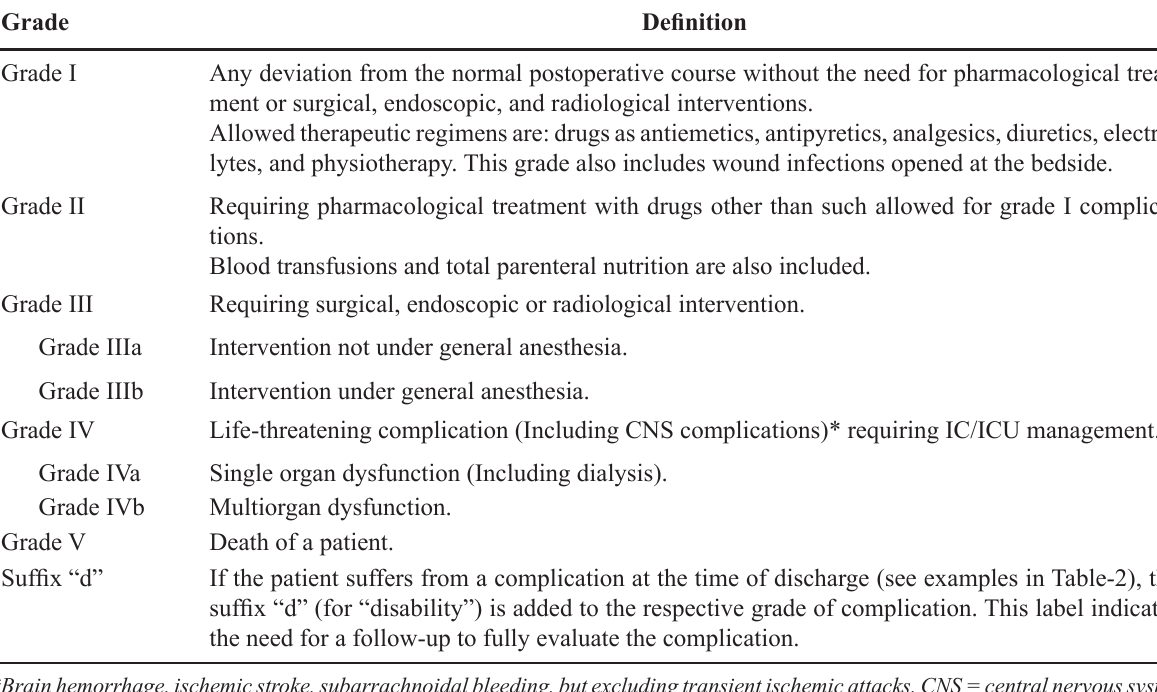
Table 1 – Update classification of surgical complications.